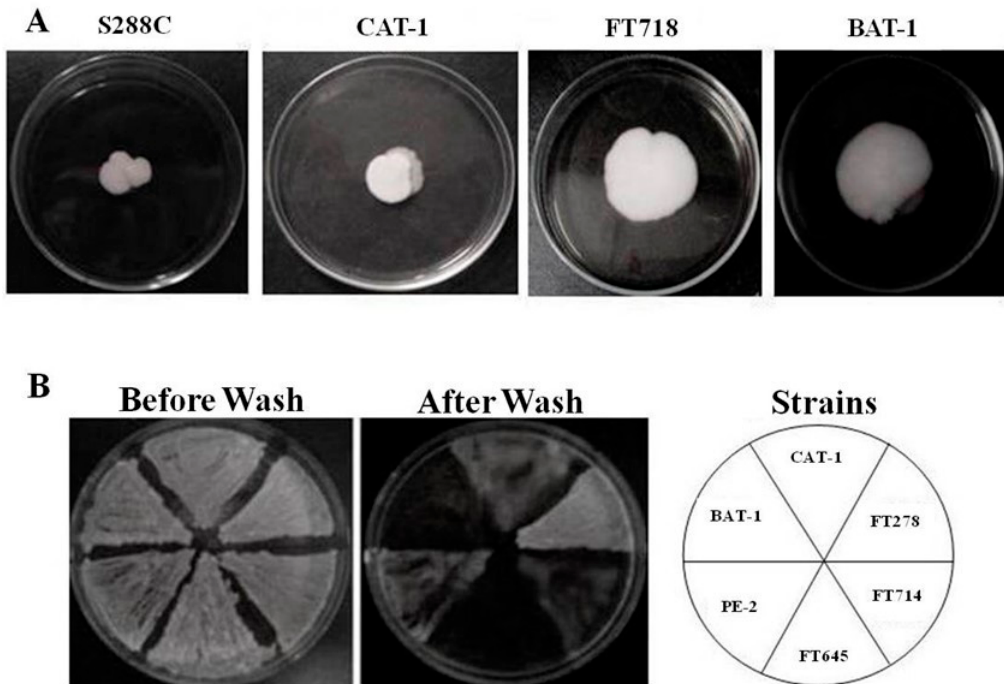
Figure 5. Biofilm formation and invasive growth by the analyzed industrial fuel-ethanol yeast strains. ( A ) Examples of biofilms (mats) produced by the indicated strains after 5 days in low agar (0.3%) plates. ( B ) Invasive growth, scored as adhesion to agar surfaces, was determined by patching the yeast cells on YPD plates and incubation for 5 days. The plate was documented before and after gentle washing with water. Strains BAT-1 and FT645 were considered non-adhesive (“–” in Table 2), while the other strains showed different strengths of invasive growth (scored “+” to “+++” in Table 2). Table 2. Biofilm, invasive growth, and FLO gene polymorphisms of the industrial strains analyzed in this